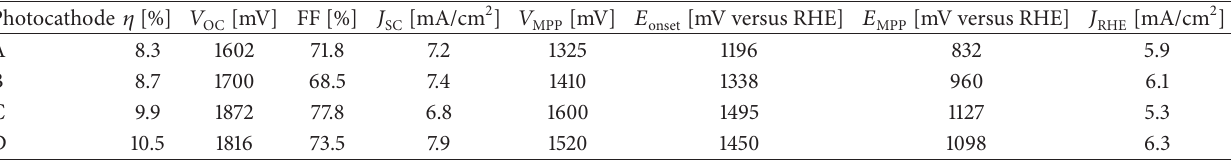
Table 3: Photovoltaic and PEC parameters of a-Si:H/a-Si:H tandem junction based photocathodes.